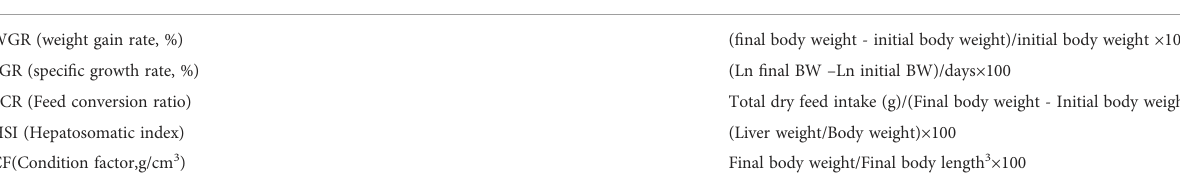
TABLE 2 The calculation method of growth parameters. The growth